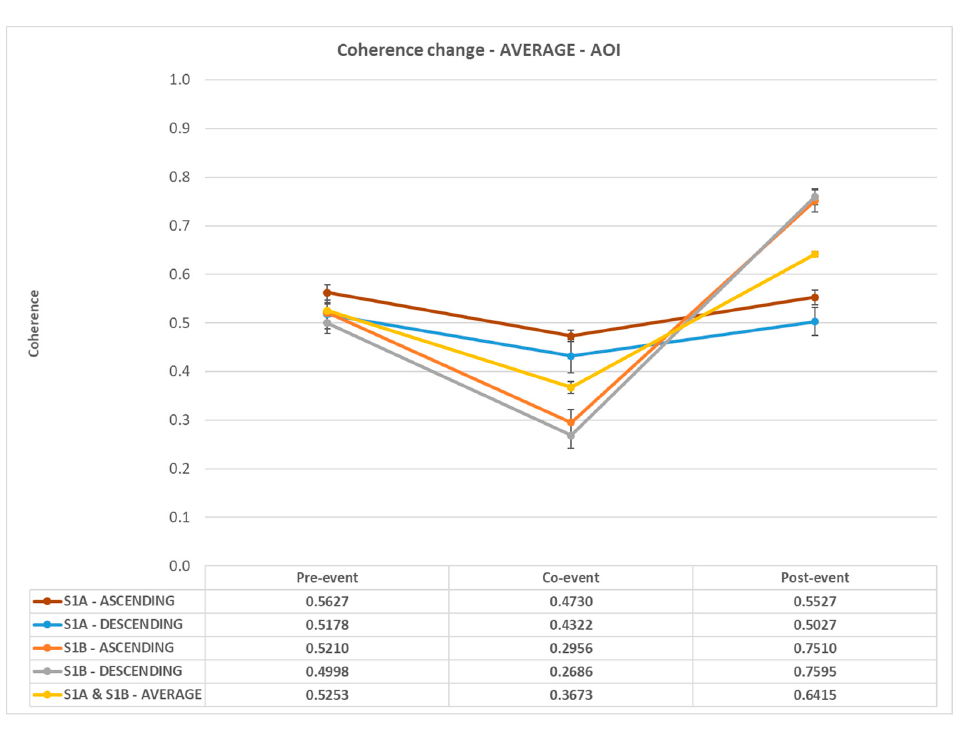
Figure 14. Average coherence changes within the boundaries of the Area Of Interest (AOI).